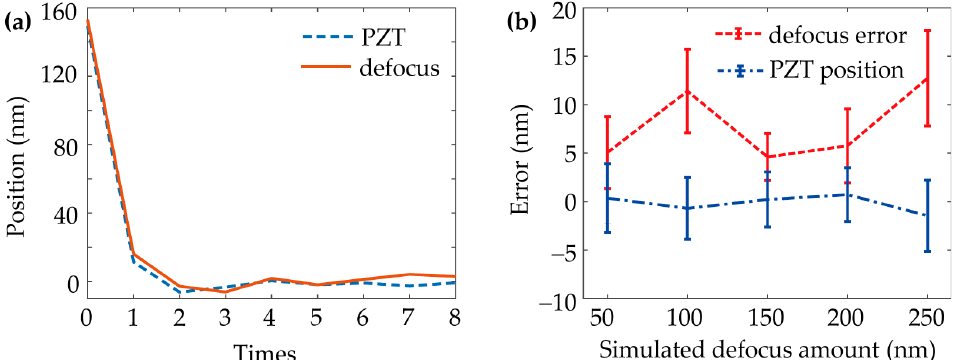
Figure 4. Measurement and compensation experiment of the simulated defocus amount. ( a ) After moving the substrate 150 nm by the PZT, 15 compensations were performed (eight times shown). The defocus amount was measured and the PZT position was recorded after each compensation. ( b ) The experiment in ( a ) was carried out 10 times for di ff erent simulated defocus amounts. Defocus errors were calculated for repetitive measurement accuracy, where the defocus error was the di ff er- ence between the measured defocus amount and the recorded PZT position immediately after the substrate defocused. The PZT position errors were obtained by analyzing the PZT positions rec- orded after compensations.